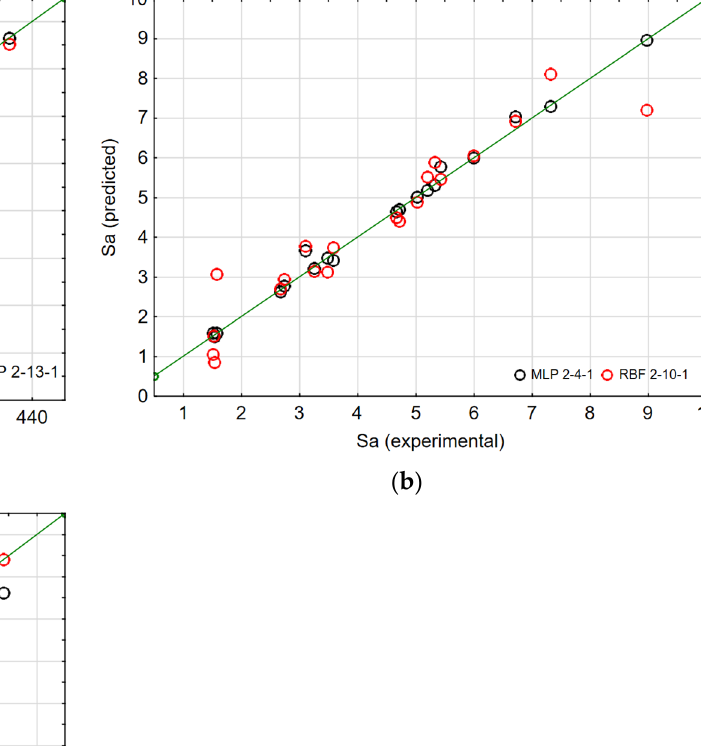
18 of 23 Table 9. Selected networks based on quality (learning, validation), errors (learning, validation). Network Name